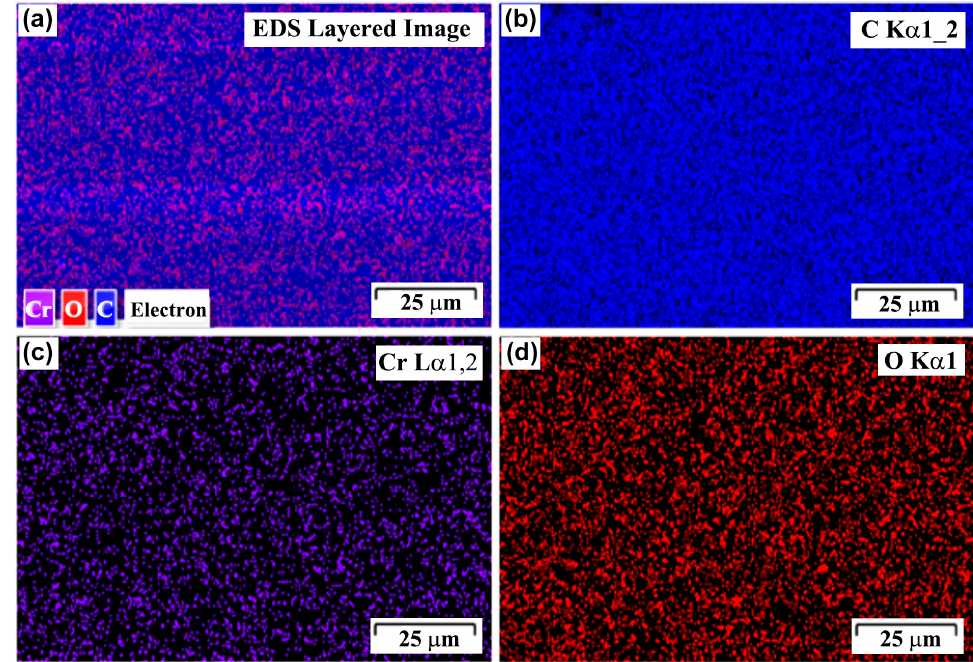
Figure 2. EDS mapping at the ABS substrate treated by Cr ion bombardment for 3 min: ( a ) EDS layered image, ( b ) C, ( c ) Cr, and ( d ) O.